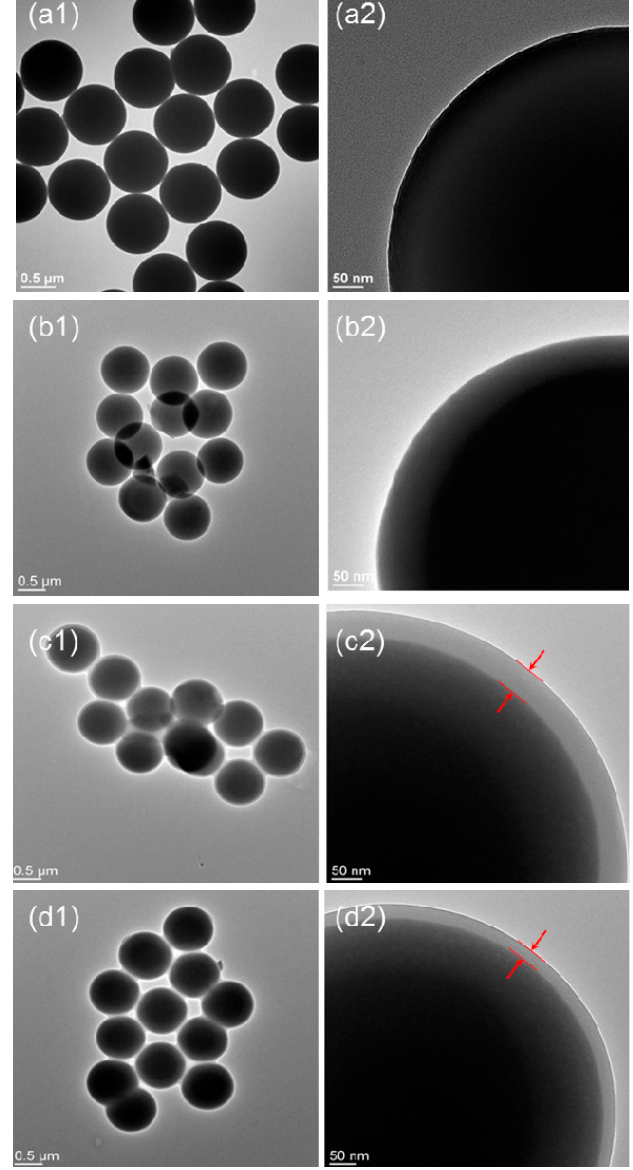
Figure 5. TEM images of ( a ) bare silica microspheres; ( b ) BiBB-functionalized silica microspheres; and SPMs incubated ( c ) below and ( d ) above the LCST. The red arrows indicate the thickness change of PNIPAAM below and above LCST, repsectively (1: large scale of samples; 2: zoom-in scale of the coressponding samples).